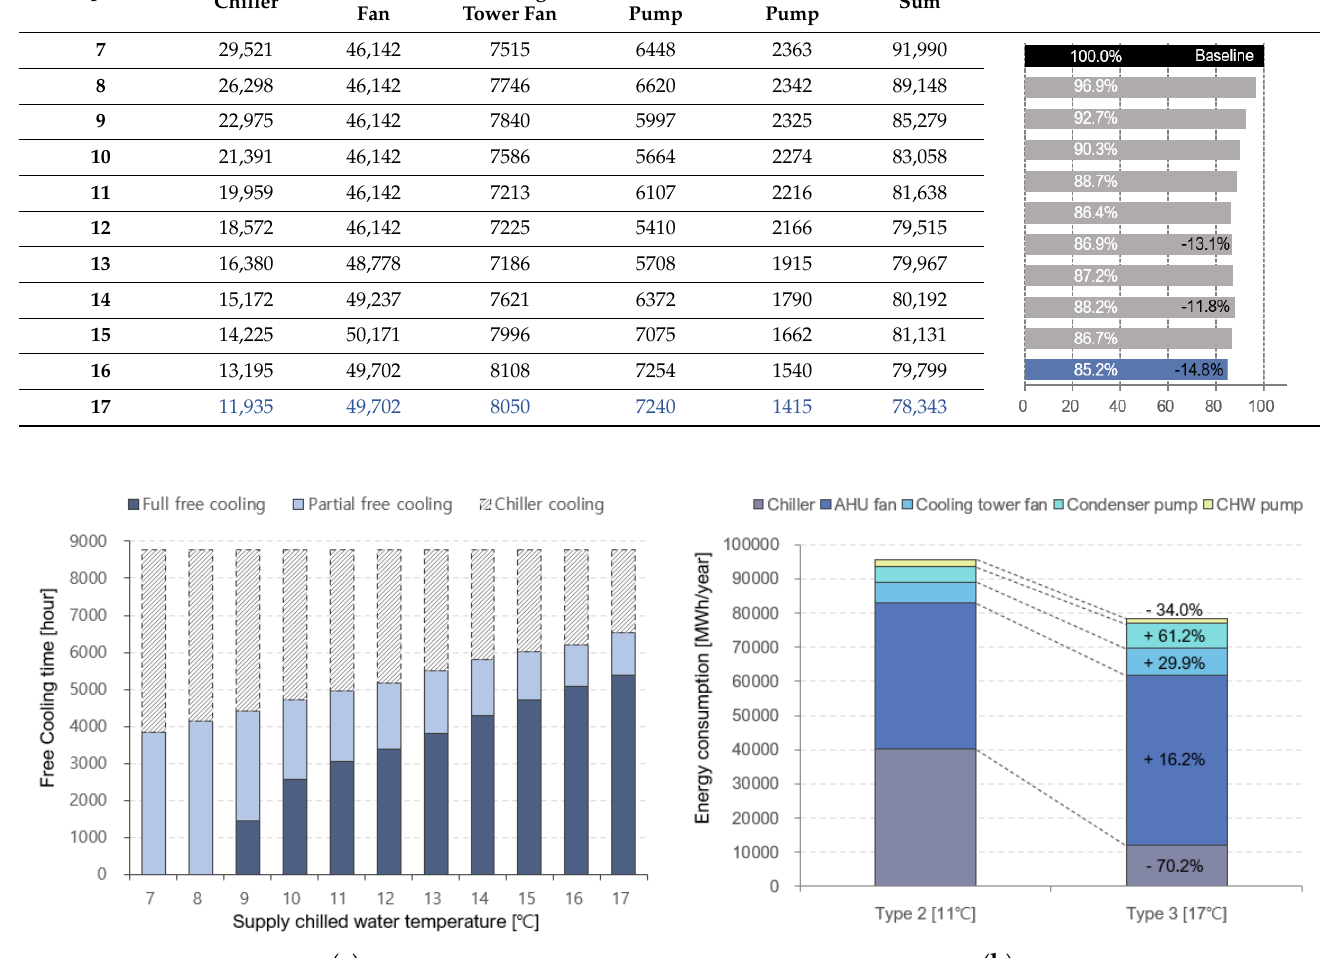
Table 4. Variation in energy consumption with changes in the chilled water set temperature of WSE (type 3). The value marked in red indicate increased energy consumption compared to 7 °C. The value shown in blue indicates the optimum value among the set temperature of chilled water in the range of 7 – 17 °C. CHW Set Temp. ( ◦ C)